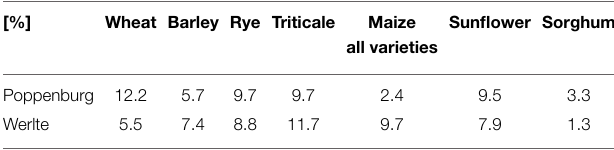
TABLE 1 | Validation of the BioSTAR crop model with measured data at two test